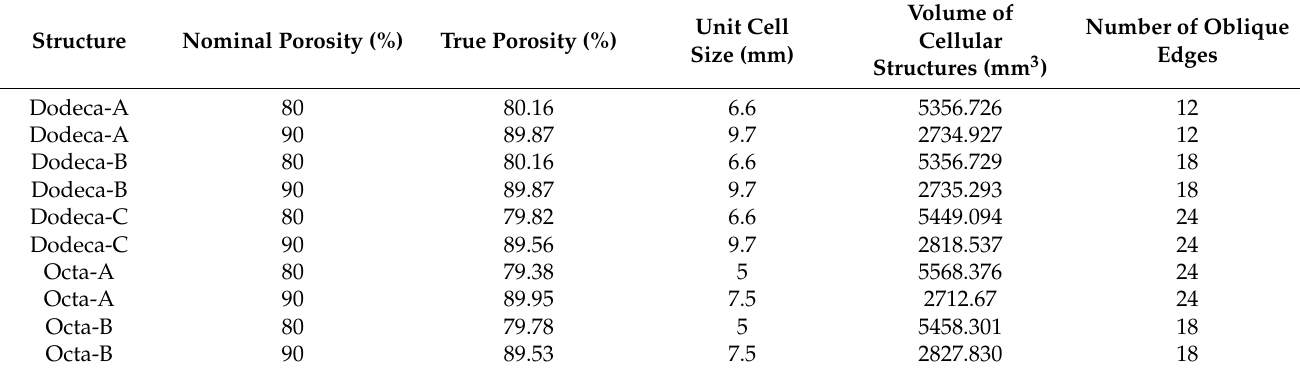
Table 1. Specific geometric parameters of the CAD models.